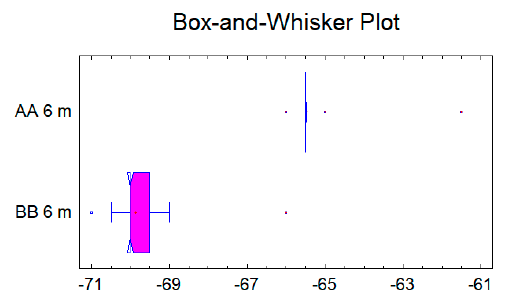
Figure 8. Histogram for reading distance 6 m.